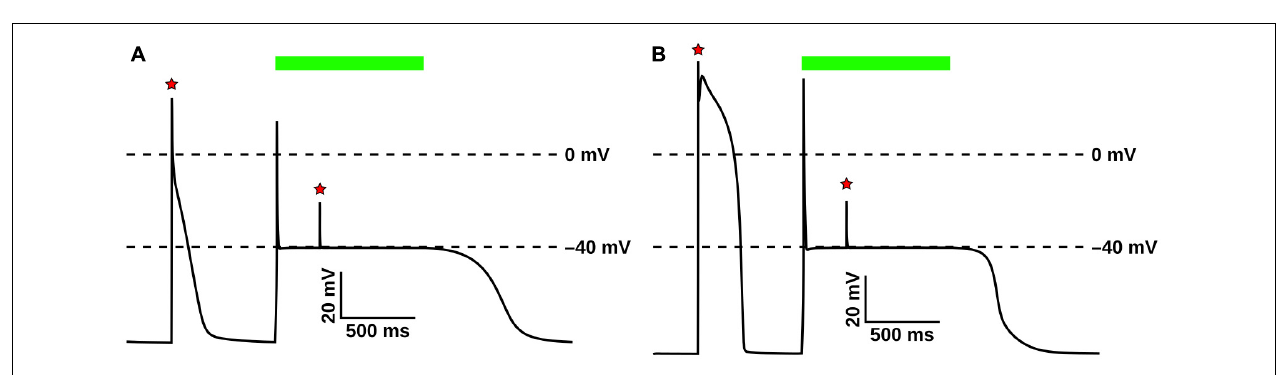
FIGURE 4 | Evaluation of GtACR1 currents upon illumination in single cell simulations. Light-elicited GtACR1 currents suppressed action potential formation in simulated atrial (A) or ventricular (B) myocyte models. Red stars show timing of electrical stimuli (30 pA/pF) and green bars represent the interval of illumination with green light (515 nm; 1.00 mW/mm 2 ; 1000 ms).